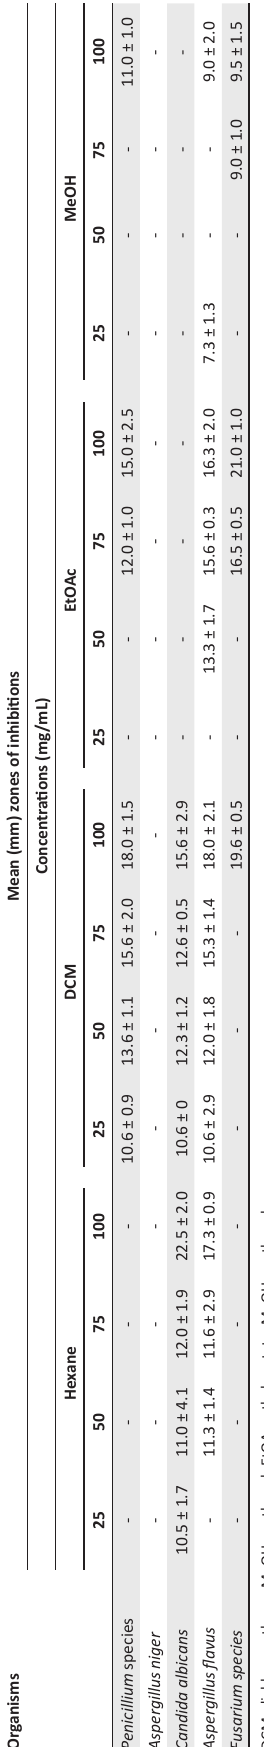
FIGURE 2: IC values of dichloromethane and ethyl acetate extracts in 2, 50 2-diphenyl-1-picrylhydrazyl assay. DCM, dichloromethane; EtOAc, Ethyl